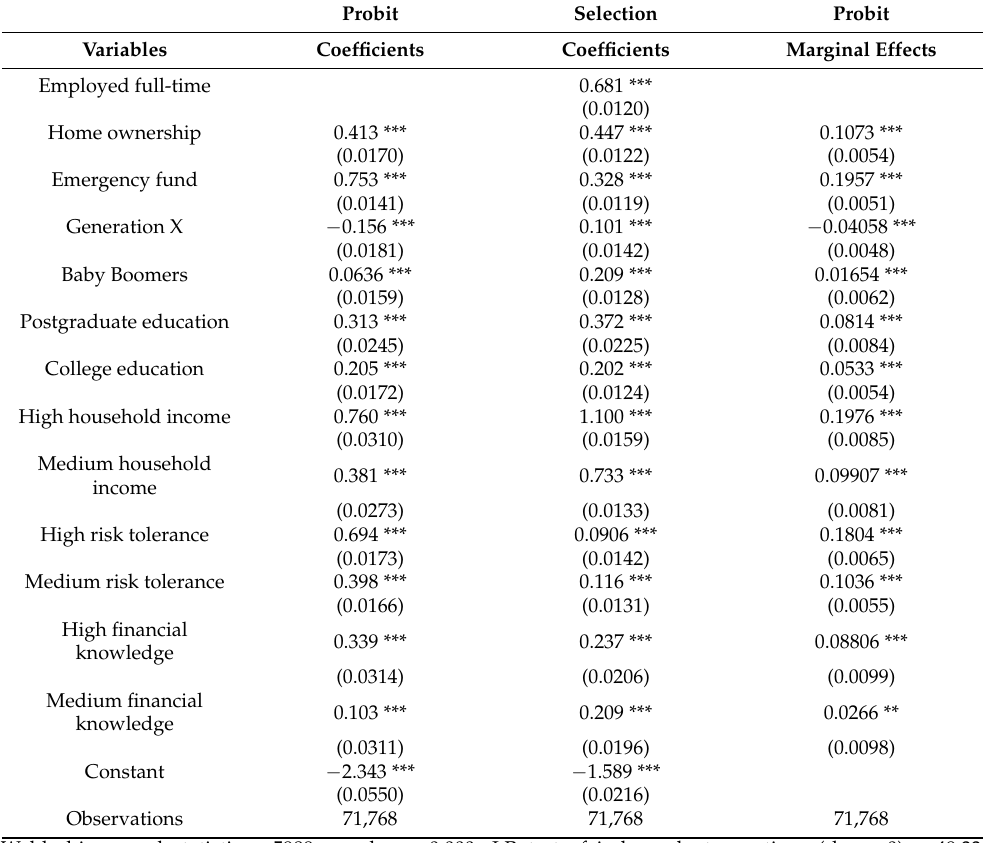
Table 3. Probit model with sample